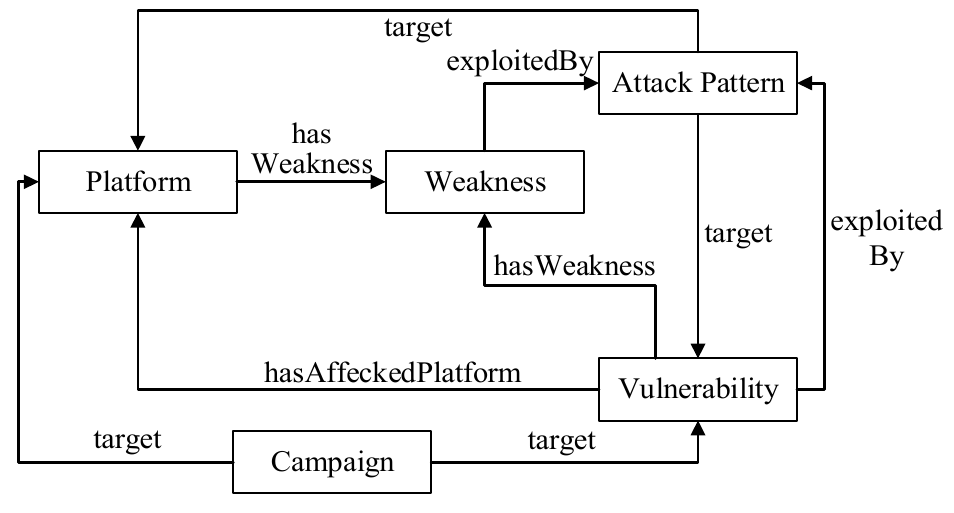
Figure 3. Top classes of IoTSTO. Table 1. Level 2 and level 3 ontology class definitions.